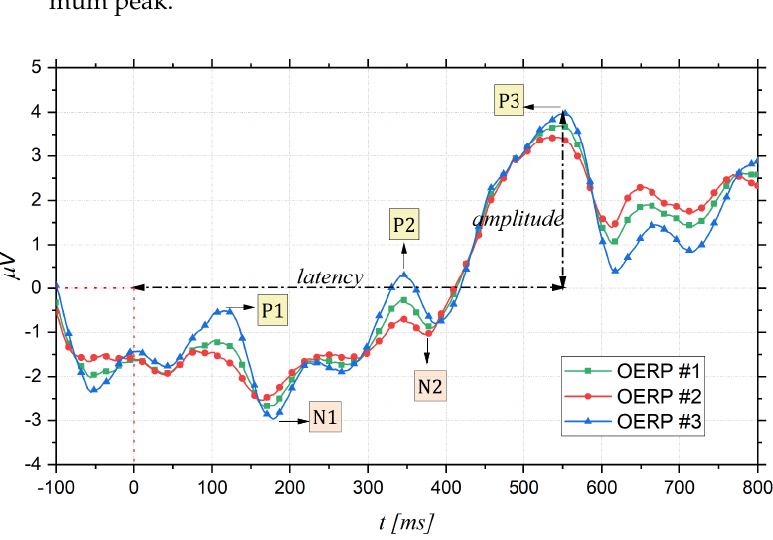
Figure 1. Examples of OERPs: peak amplitude is measured from baseline (0 µ V) and peak latency from stimulus onset (0